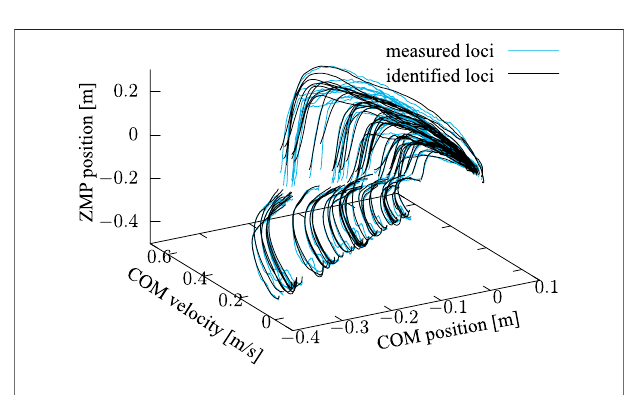
FIGURE 14 | Trajectories of x - _ x - x Z measured (cyan) and reproduced (black) from identi fi ed parameters based on Eq. 16 . The latter qualitatively show good fi ts to the former due to the additional term of inertial torque about COM.